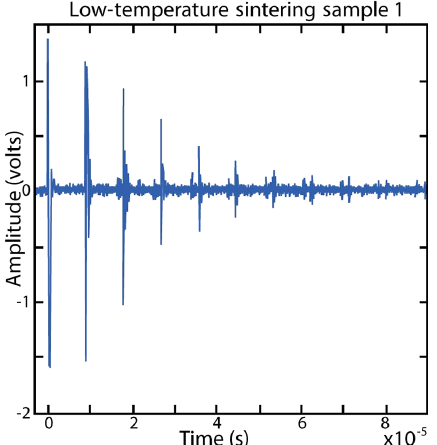
Figure 5. Surface of the steel substrate after the induction-sintering deposition process.